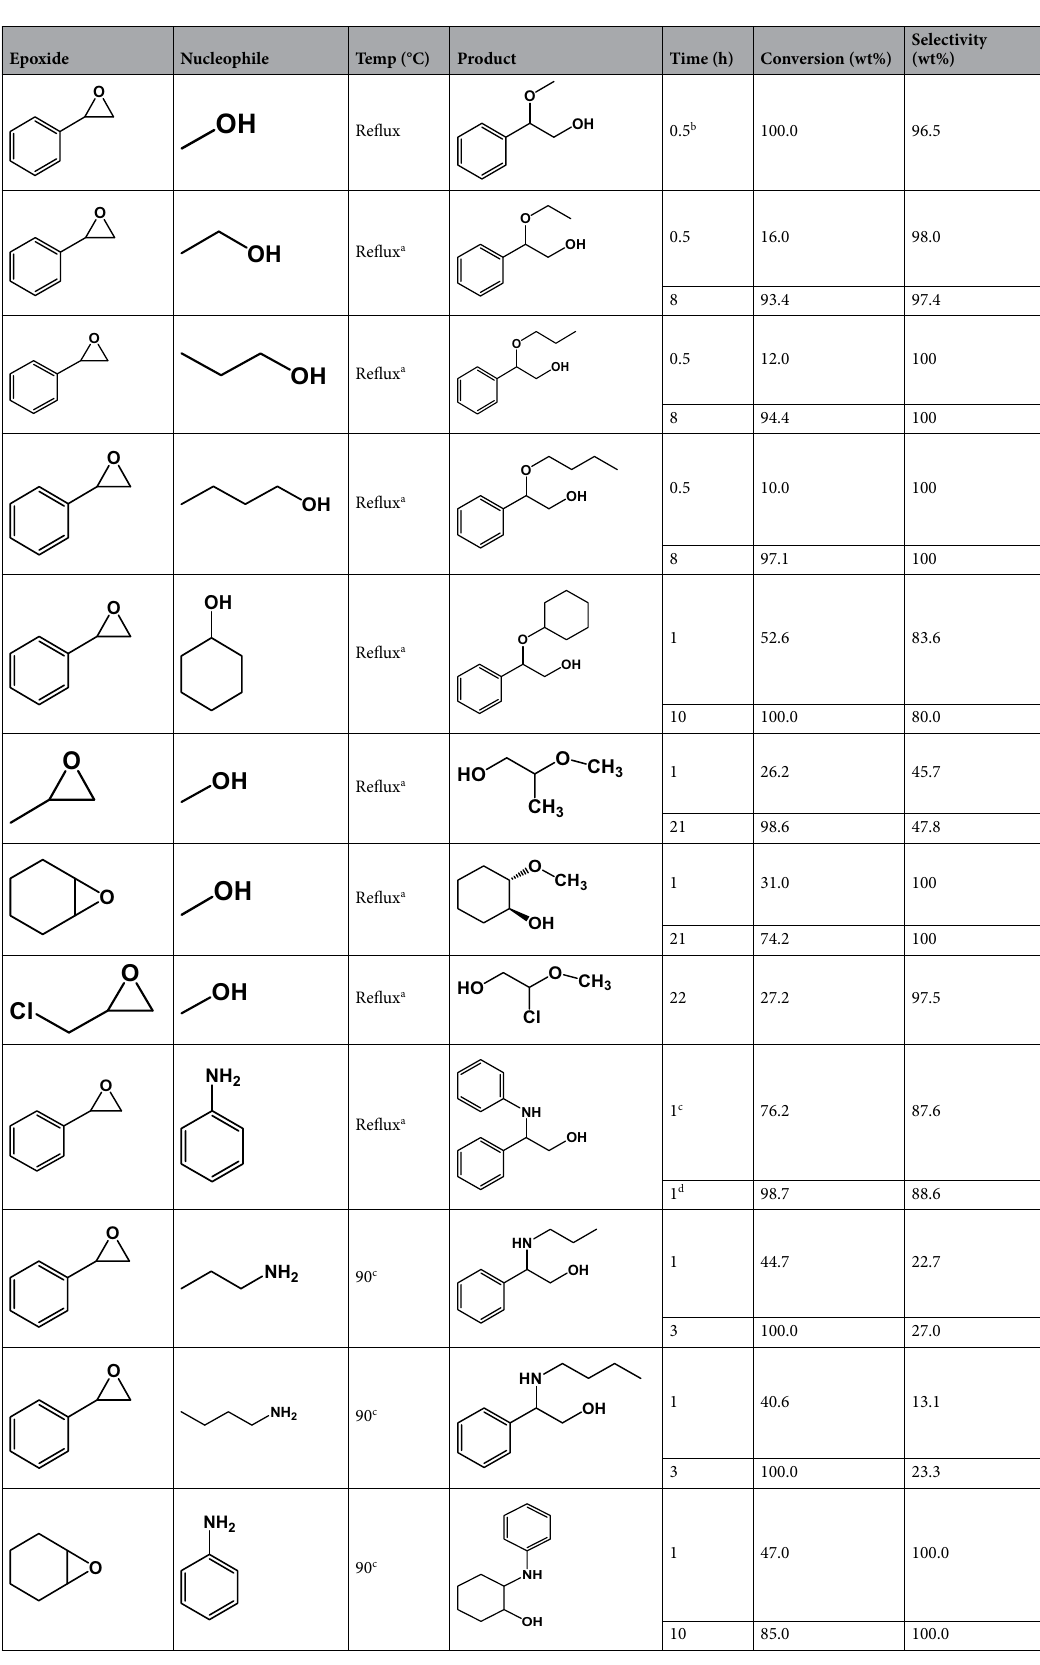
b 2 -T-350) (0.40 g), reaction temp = reflux temp;